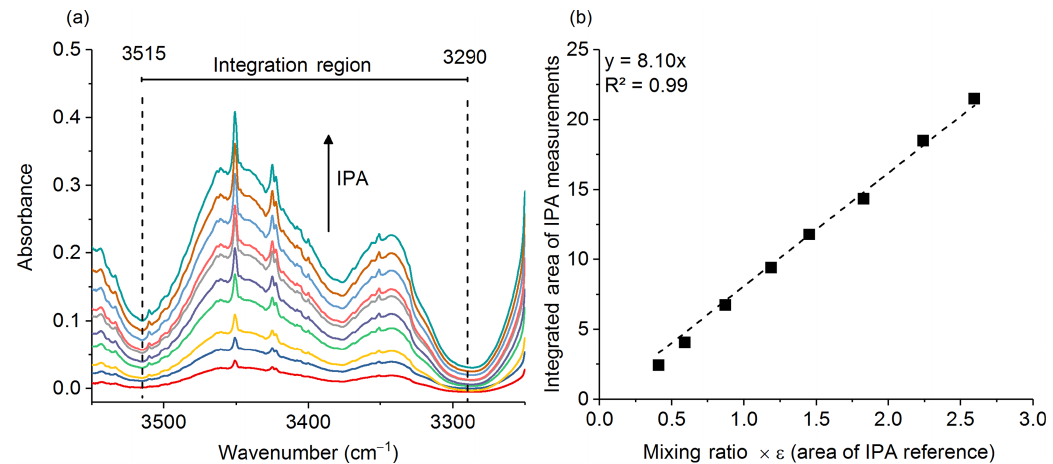
Figure 1. (a) Multiple burden spectra of dry IPA for 10 measurements at varying pressures. The dashed lines represent the integration limits used for spectral integration. (b) Calibration plot with regression line for IPA measurements. The slope of the regression is the path length in meters. Table 2. Gas-phase species identified via FTIR, vibrational assignments (Chakraborty et al., 2016; Ghosh and Günthard, 1981; Es-Sebbar et al., 2014; Lord and Venkateswarlu, 1952; Hamada et al., 1985; Hollenstein and Günthard, 1971), and spectral domains used for spectral fit and